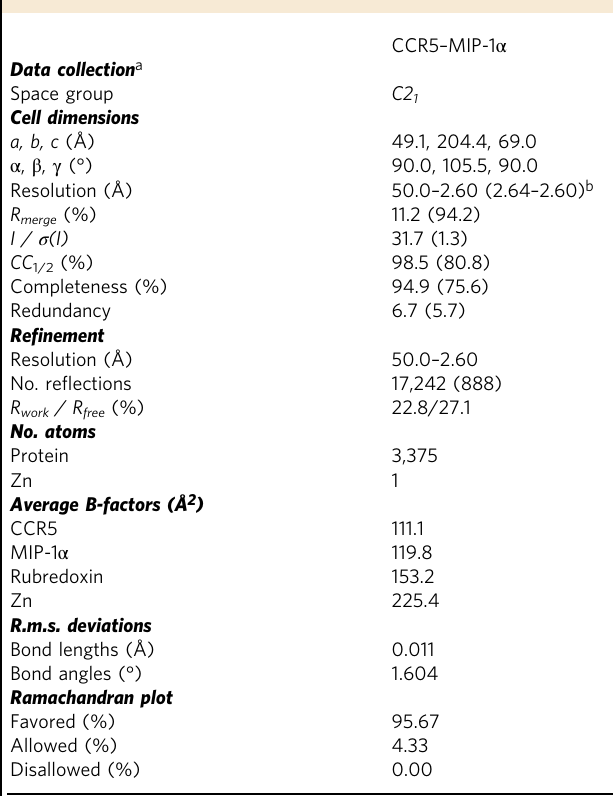
Table 2 X-ray data collection and re fi nement statistics of CCR5 – MIP-1 α complex